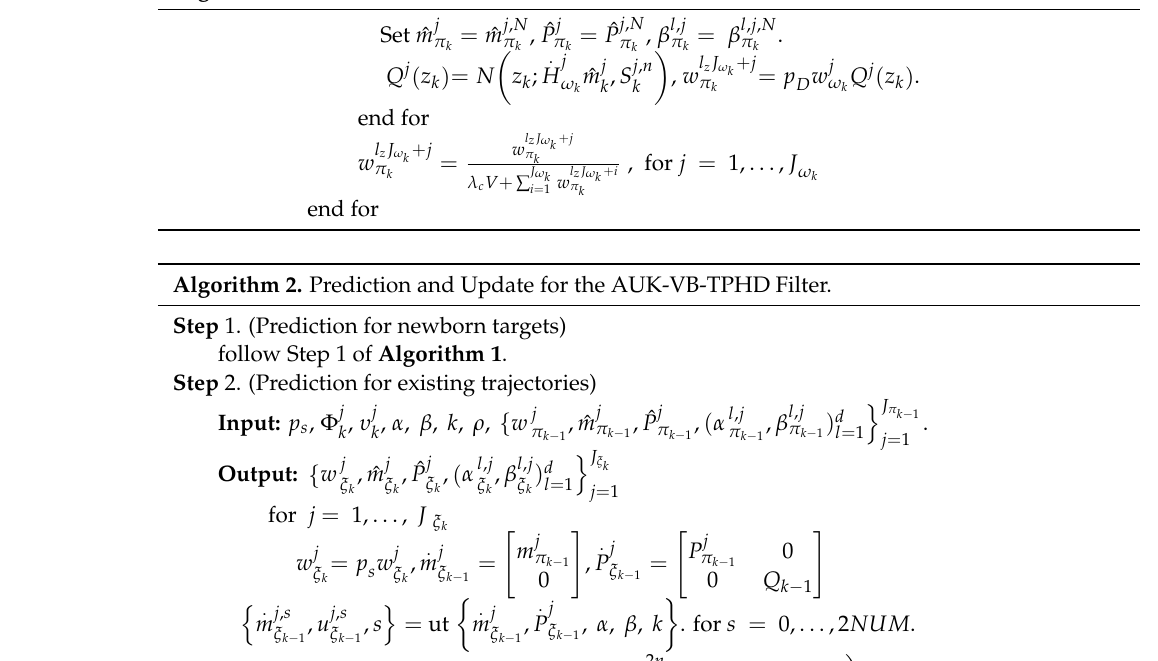
Algorithm 1. Cont.